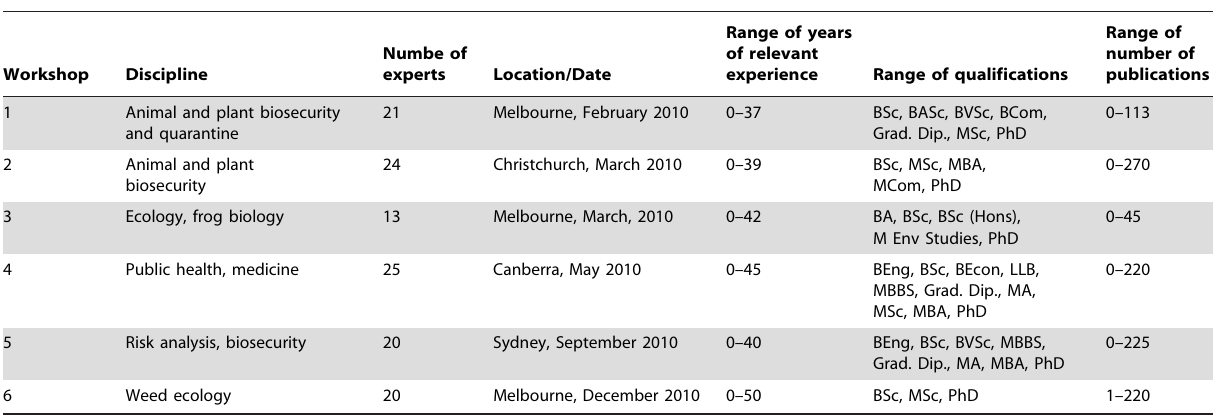
Table 1. Characteristics of the expert